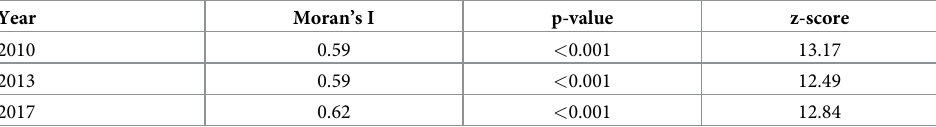
Table 2. Spatial autocorrelation between sachet consumption and household density in 2010, 2013 and 2017.